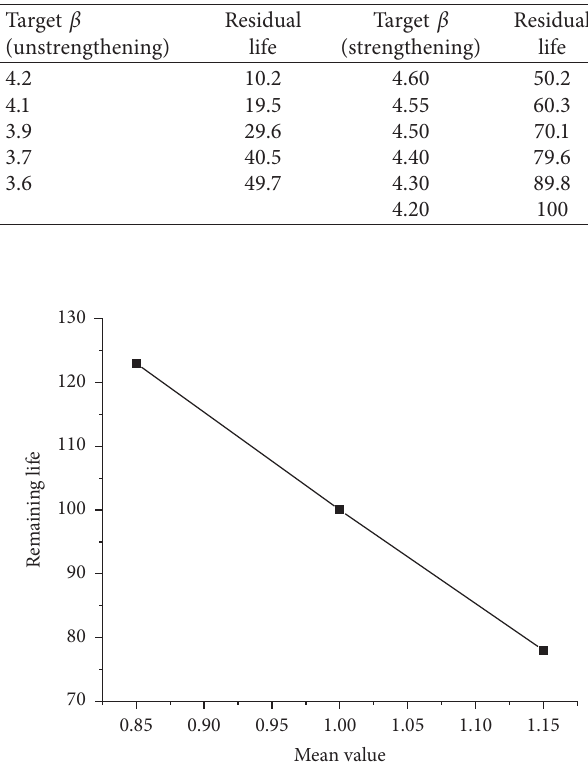
Figure 6: Influence of mean value of dead